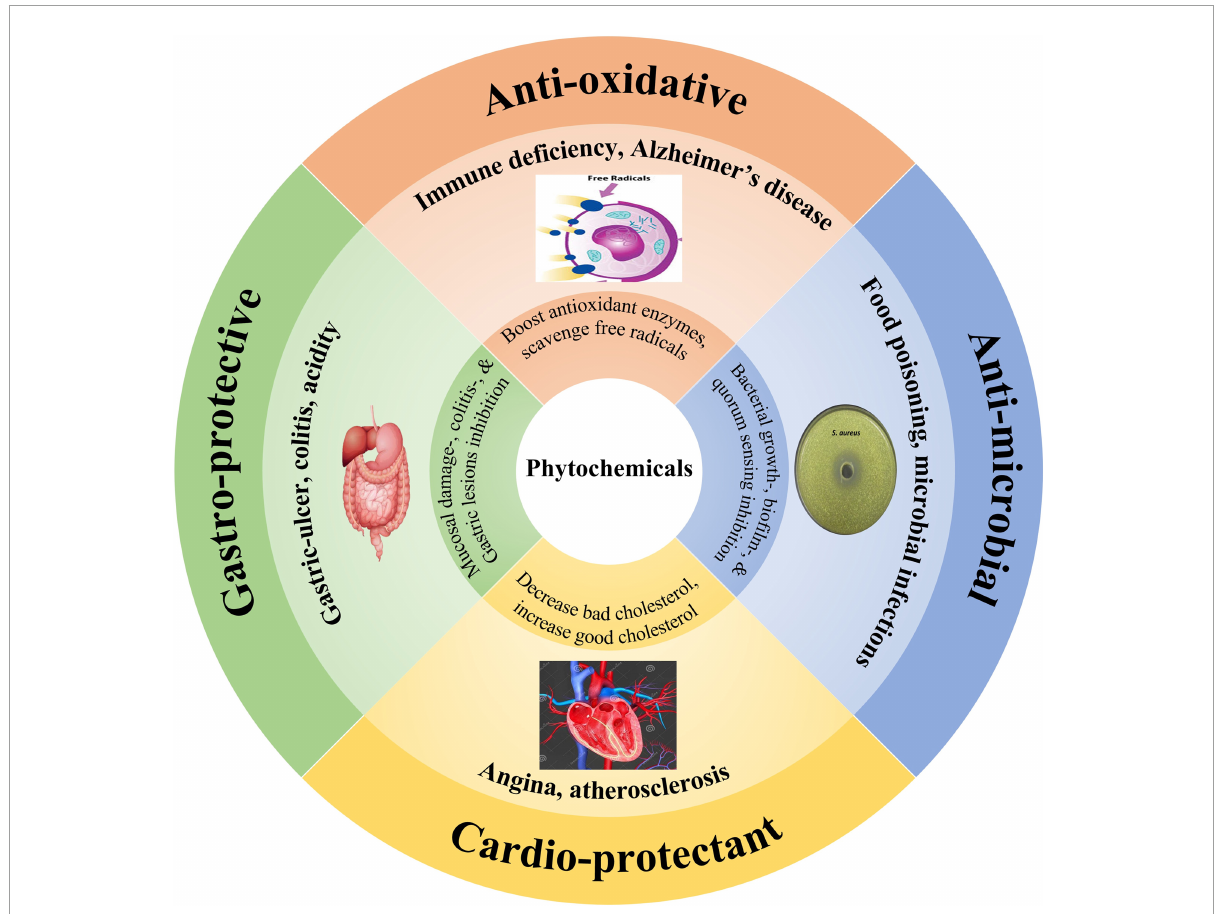
FIGURE3 Therapeutic applications of cardamom phytochemicals, including anti-oxidative (cell image indicating free radicals deterioration vs. protection by the antioxidants), anti-microbial (petri-plate showing bacterial growth inhibition), cardio-protective (heart and arteries elaborating their beneficial effects), and gastro-protective properties (digestive system symbol signifying their stomach health-promoting